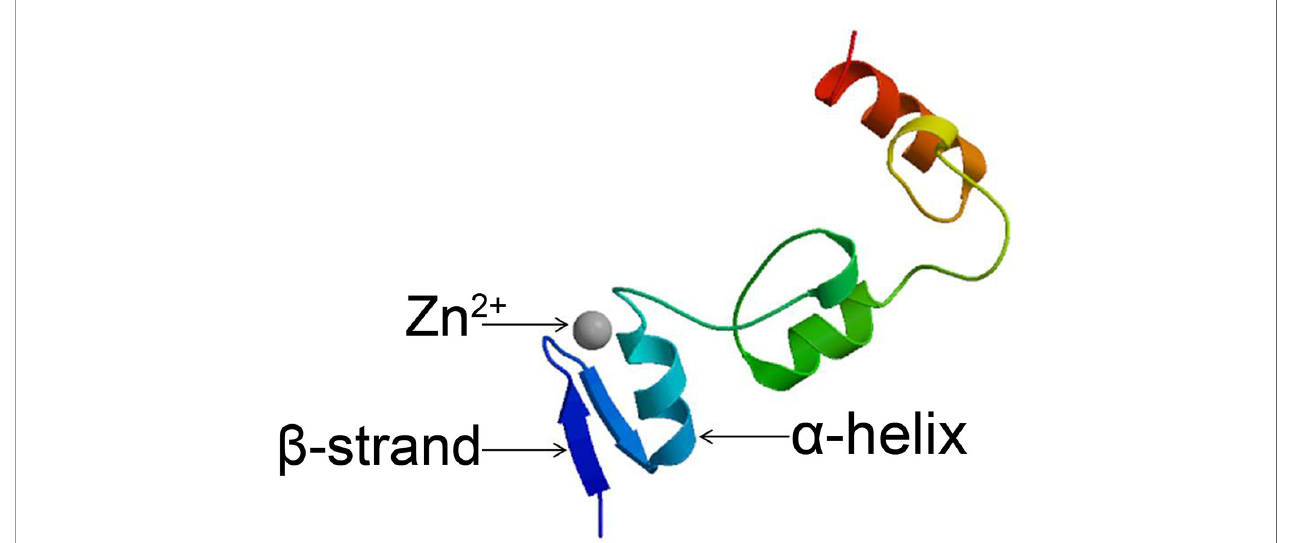
FIGURE 1 | Structure of C2H2 zinc fi nger proteins. Structural model of the Arabidopsis C2H2 zinc fi nger protein STZ produced using the Protein Model Portal